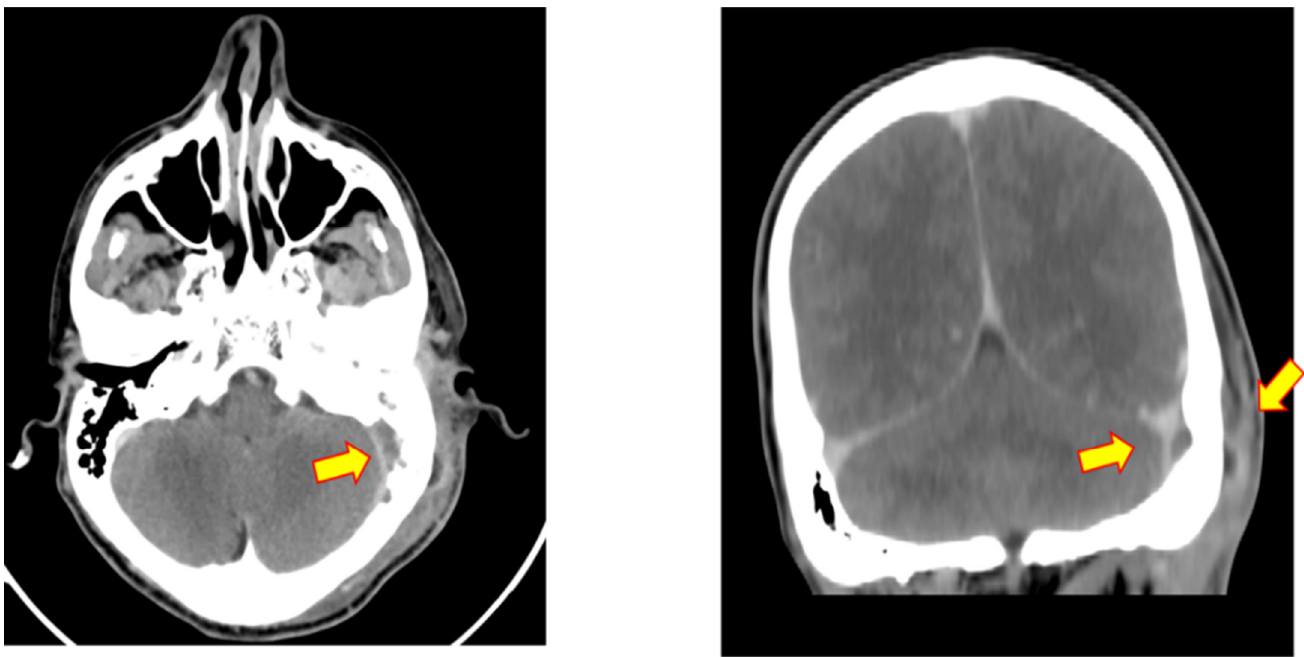
Figure 2. Pre-operative CT scan—case 1. Axial and coronal reconstruction post-contrast head CT shows a large filling defect and enhancement around the sigmoid sinus (delta sign, consistent with sigmoid sinus thrombosis (inner yellow arrow). In the soft tissue there are mall subperiosteal abscess formations (outer yellow arrow).